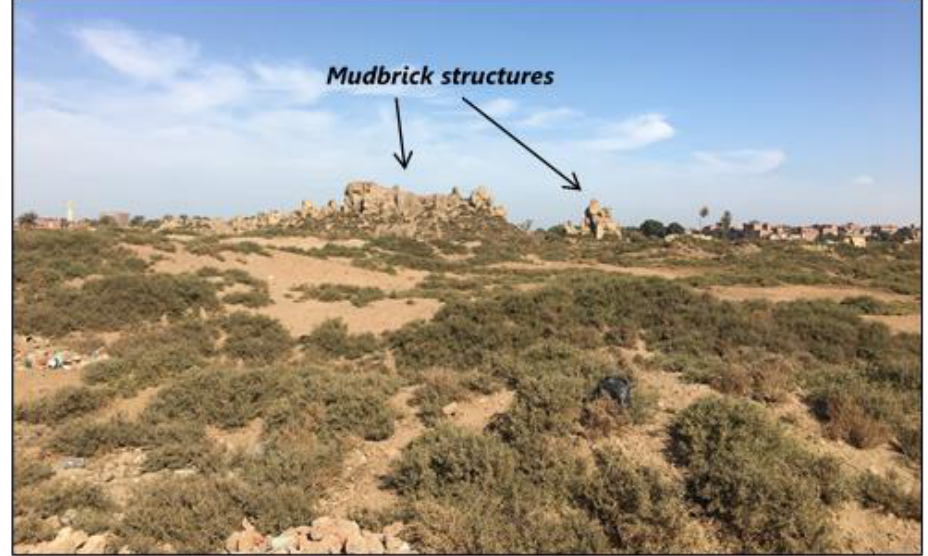
Figure 3 . Deteriorating remnants of mudbrick structures at Hermopolis (photo taken by author). Figure 3. Deteriorating remnants of mudbrick structures at Hermopolis (photo taken by